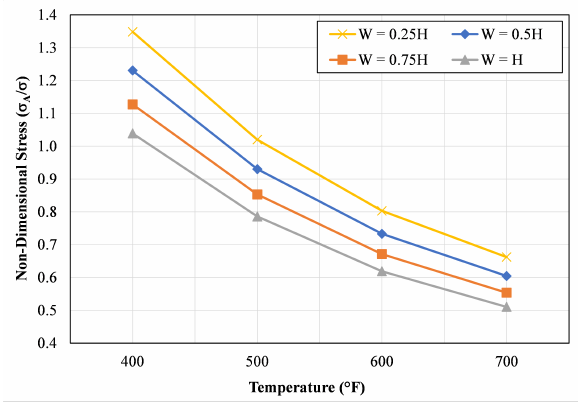
Figure 9: Relationship between σ A / σ on the expansion loop pipe 20-inch diameter with increasing temperature.